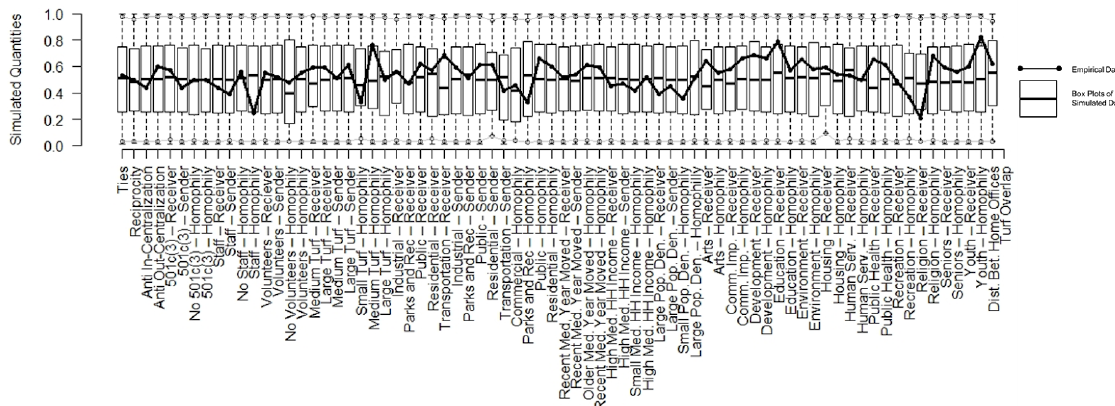
Figure A4.1: Goodness of Fit for Philadelphia